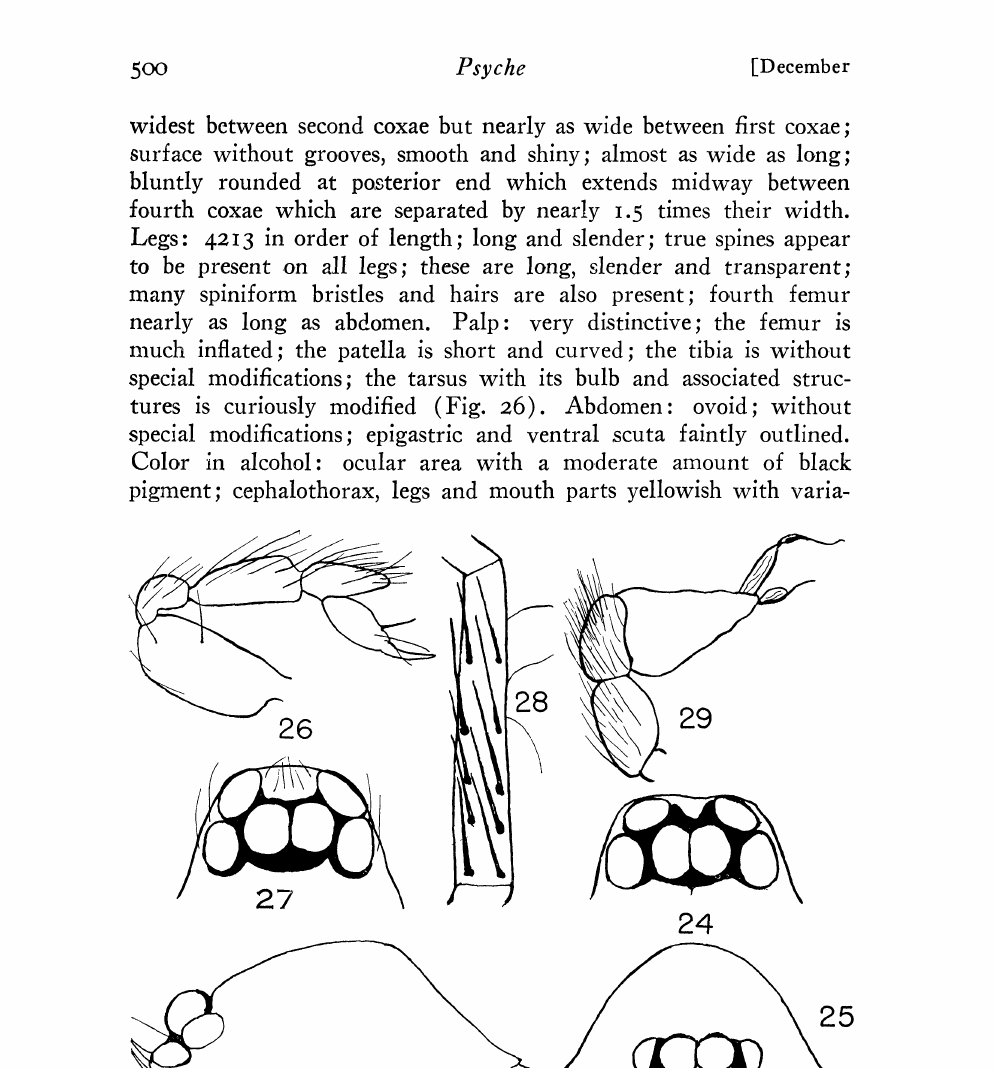
Fig. 23. Oonos donaldi Chick,ering; carapace of male; left lateral side. Figs. 24-26. Oonos itascus sp. nov. Figs. 24-25. Eyes of male holo- type from above and from in front, respectively. Fig. 26. Left male palp; prolateral view. Figs. 27-29. Oono.s tratellus sp. nov. Fig. 27. Eyes of male holotype from above. Fig. 28. Left second tibia; ventral view. Fig. 29. Left palp of male holotype; prolateral